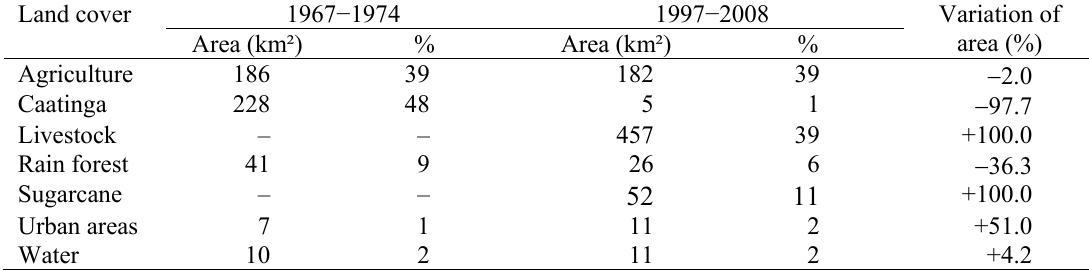
Fig. 3 Land-use and land- cover maps of the Tapacurá catchment for 1967−1974 and 1997−2008. Table 2 Land-use changes in the Tapacurá catchment